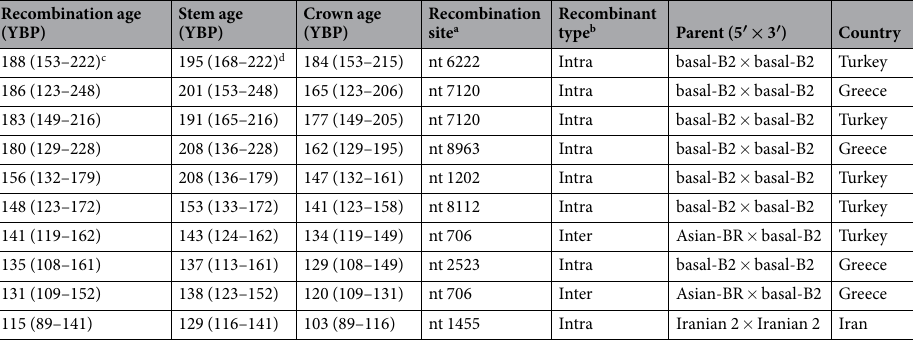
Table 2. Estimates of the timing of recombination events of turnip mosaic virus in Greece, Iran and Turkey. a The age of recombination sites in Greece, Iran and Turkey were estimated with reference to the results of our Bayesian phylogenetic analyses. Only the oldest ten recombination sites are listed. The common recombination sites in these countries were estimated from the tree including all isolates (data not shown). Nucleotide positions show locations of individual genes numbered as in the original UK 1 genome 57 . b Inter-, interlineage recombination site; intra, intralineage recombination site. c The youngest and oldest ages are shown for recombination age. The youngest and oldest ages were estimated from the stem and crown ages, respectively. Estimates are given in YBP (years before present; 2012). d 95% credibility intervals are shown in parentheses for stem and crown